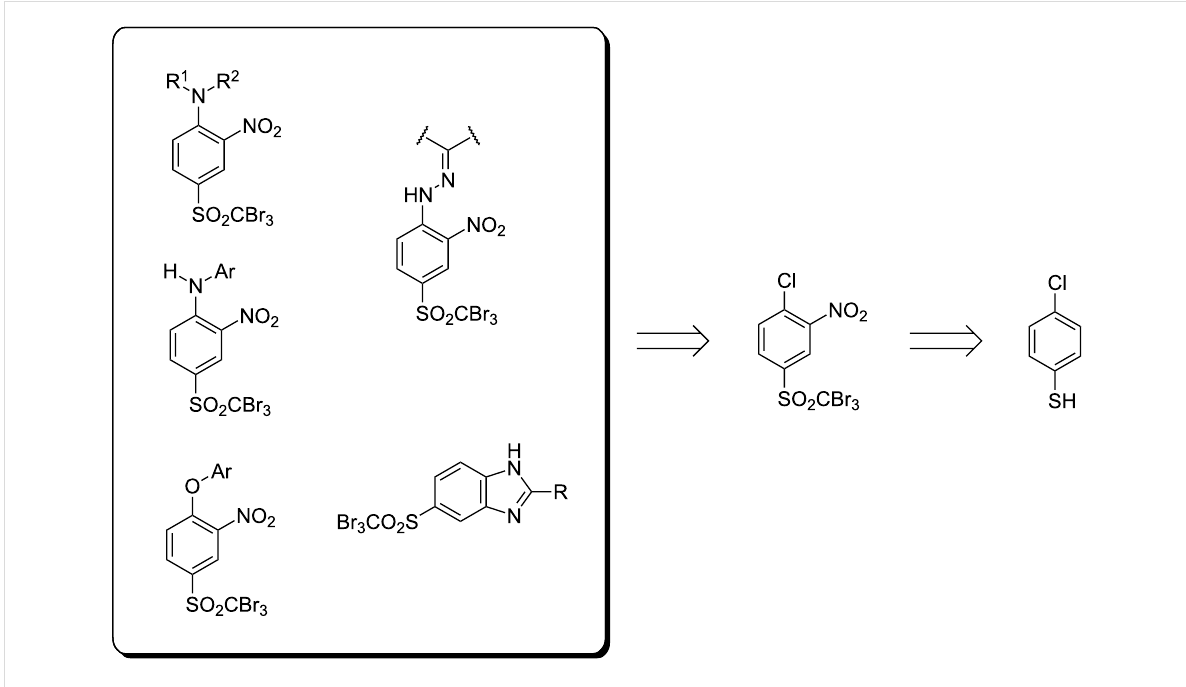
Scheme 1: Retrosynthetic analysis of the designed target